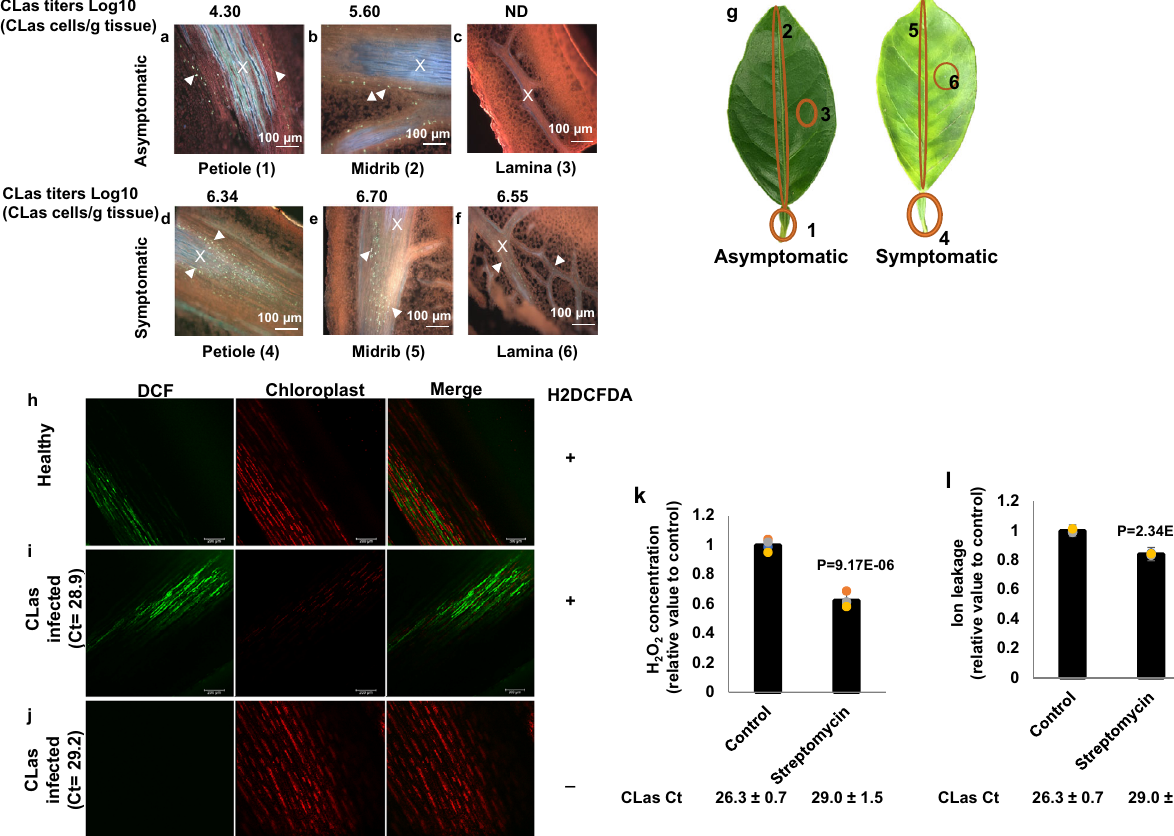
Fig. 4 CLas infection induces callose deposition, H 2 O 2 production and cell death in the phloem tissue of C. sinensis . a – f C. sinensis “ Hamlin ” leaf samples were fi xed with FAA solution overnight, sectioned and stained with 0.005% aniline blue solution prior to analysis. Xylem is marked with an X, and callose deposition is indicated with arrowheads. Asymptomatic samples: ( a ) Petiole, ( b ) Midrib, ( c ) Lamina; Symptomatic samples: ( d ) Petiole, ( e ) Midrib, and ( f ) Lamina. Pictures are representatives of 12 replicates. ND Non-detected. g schematic representation of samples used for callose deposition assays ( a – f ). CLas titers for each section were quanti fi ed by qPCR. h – j H 2 O 2 production in the phloem tissue. Healthy ( h ) and CLas-infected ( i ) C. sinensis “ Valencia ” bark tissues visualized with 2 ′ ,7 ′ -dichlorodihydro fl uorescein diacetate (H 2 DCFDA) under a confocal laser microscope. CLas infected ( j ) C. sinensis “ Valencia ” bark without H2DCFDA was used as a control. “ + ” indicates with H “ − ” indicates without H – l Effect of 2 DCFDA treatment. 2 DCFDA treatment. k killing CLas with streptomycin on H 2 O 2 concentration ( k ) and cell death ( l ) in the phloem tissue. CLas-positive 5-year-old sweet orange trees were